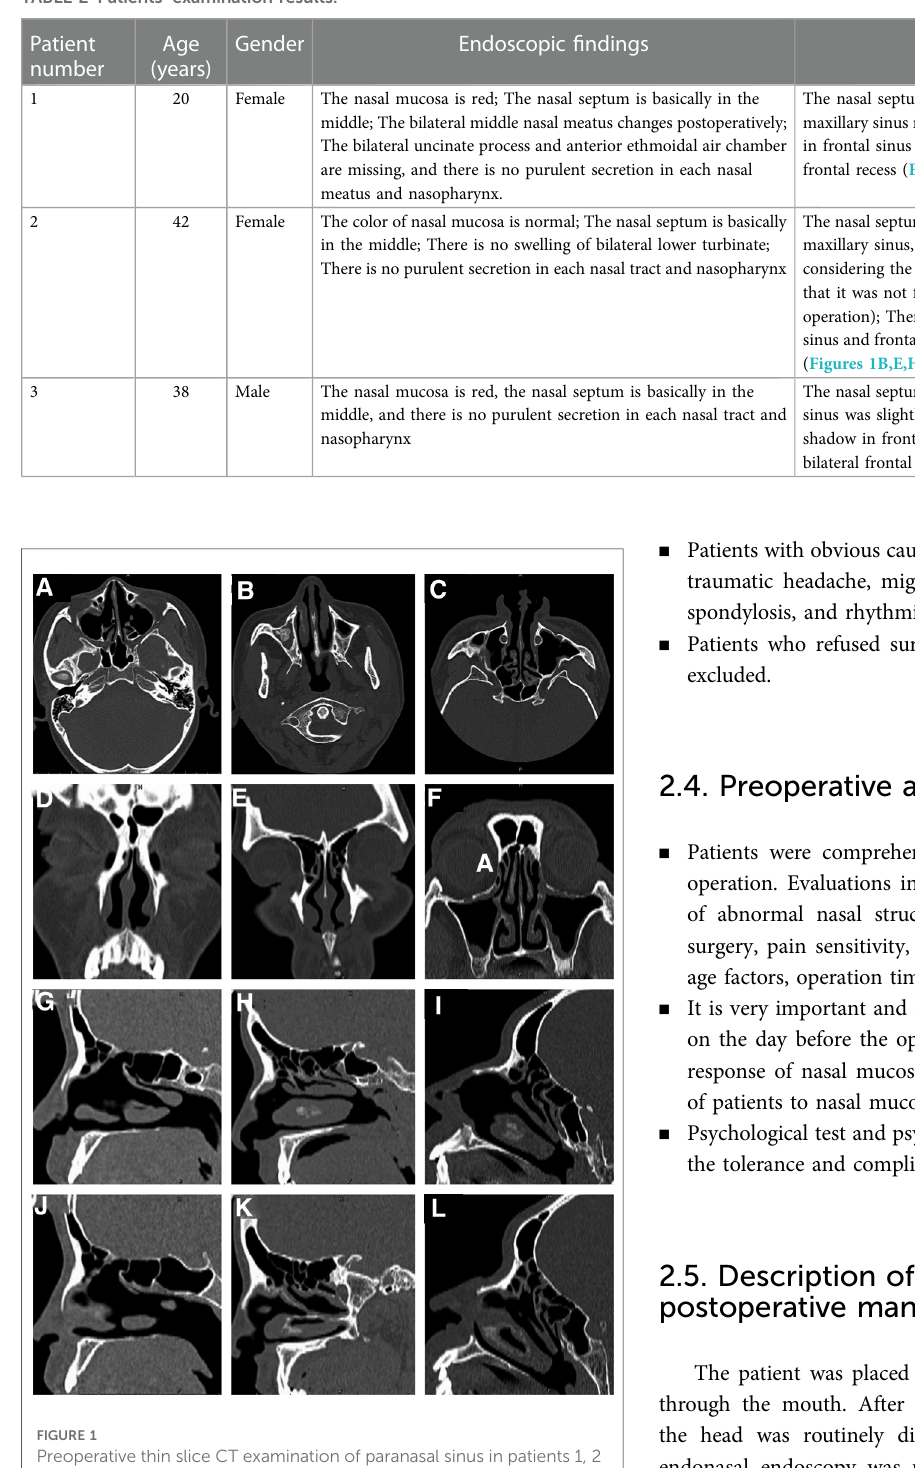
TABLE 2 Patients ’ examination results.